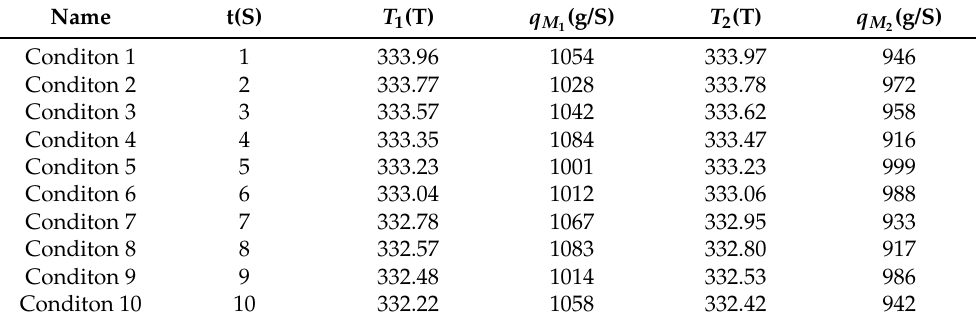
Table 4. 10 typical operational conditions in production